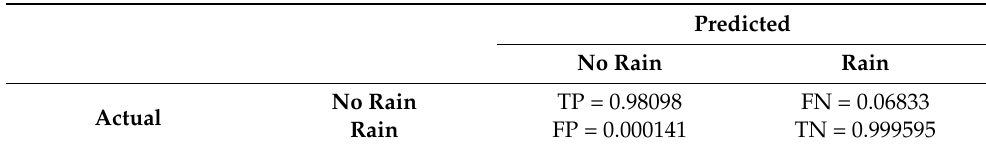
Table 7. The performance results of confusion matrix.